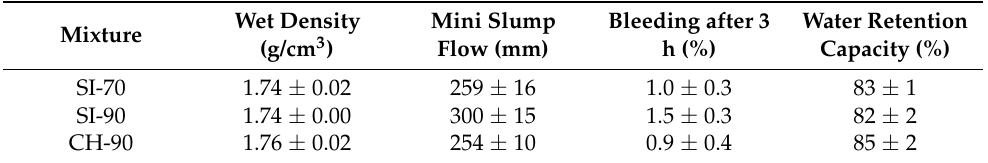
Table 4. Wet density (g/cm 3 ); mini-slump flow (mm); bleeding after 3 h (%); and water retention capacity (%) of the fresh SI and CH